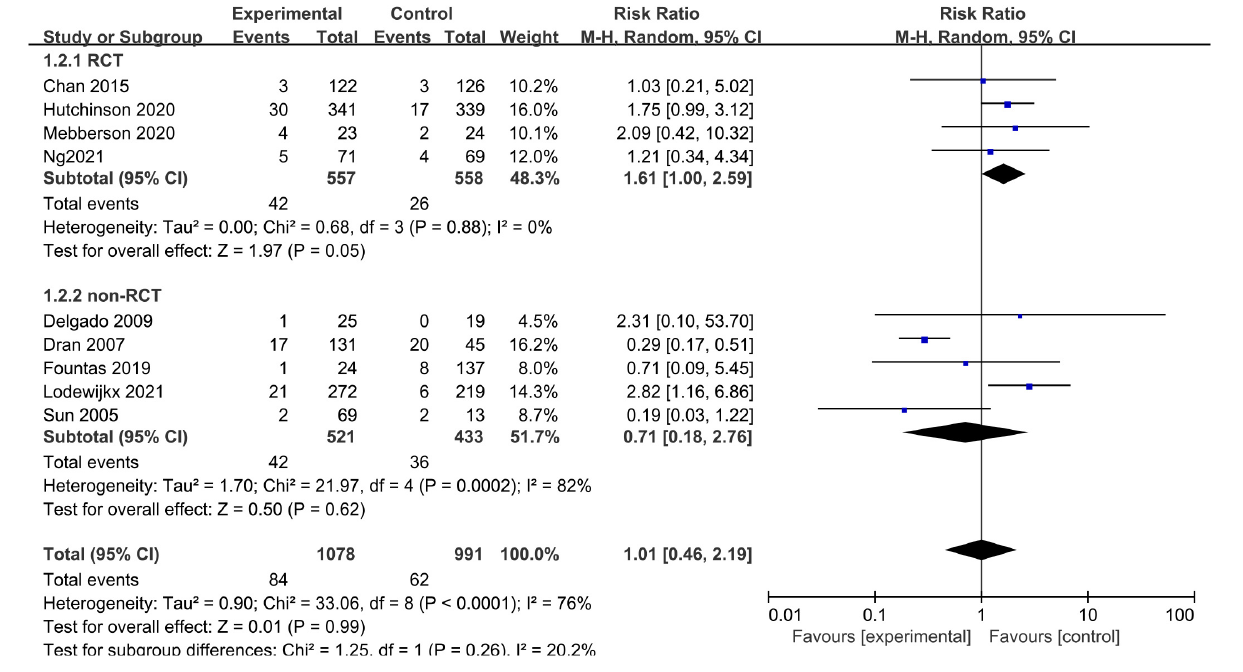
FIGURE 3 | Meta-analysis of adjuvant corticosteroid group compared to the surgery alone group on all-cause mortality.